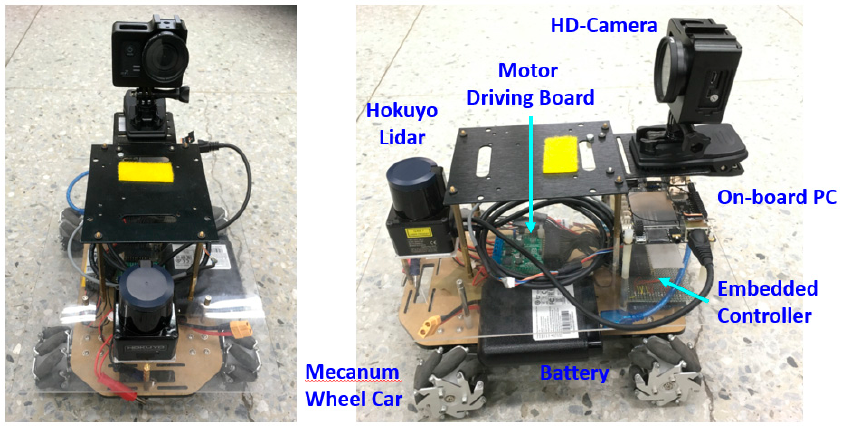
Figure 8. A LiDAR-based portable module and a moving platform.